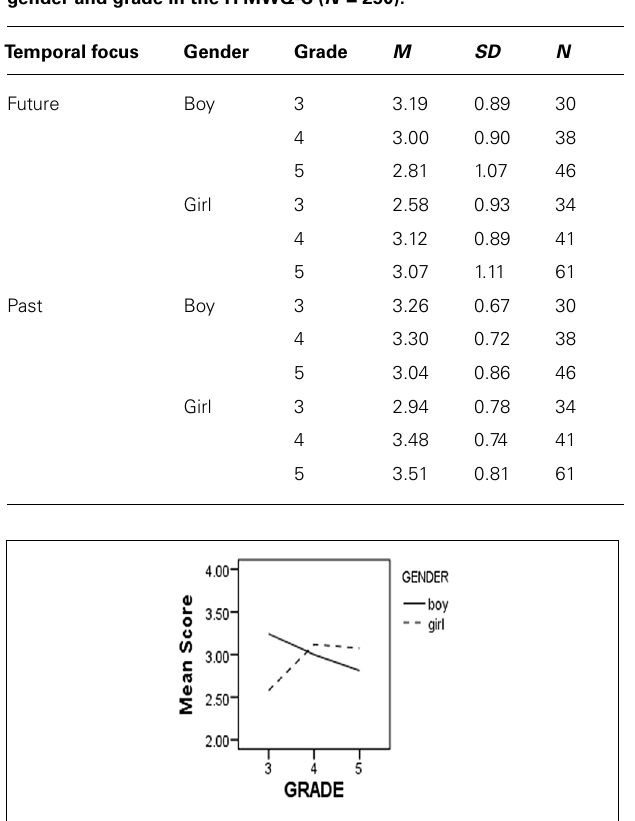
FIGURE 1 | Future dimension of children’s mind wandering.